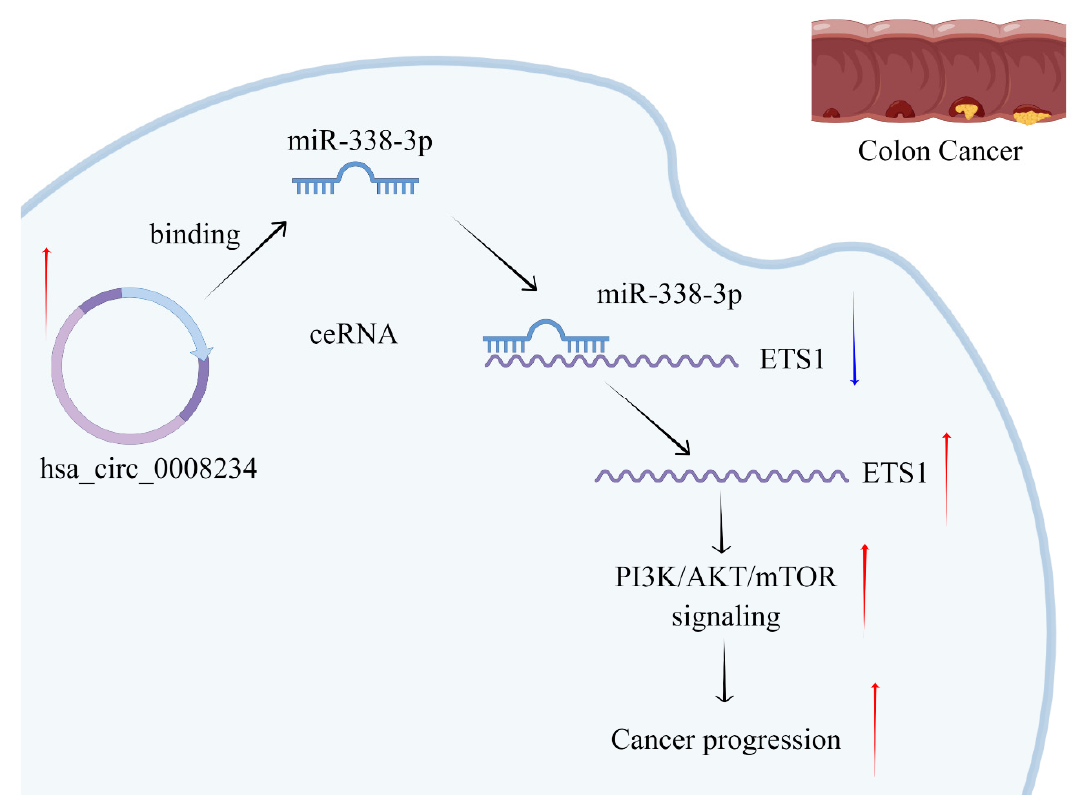
Figure 8. The putative diagram of our study.